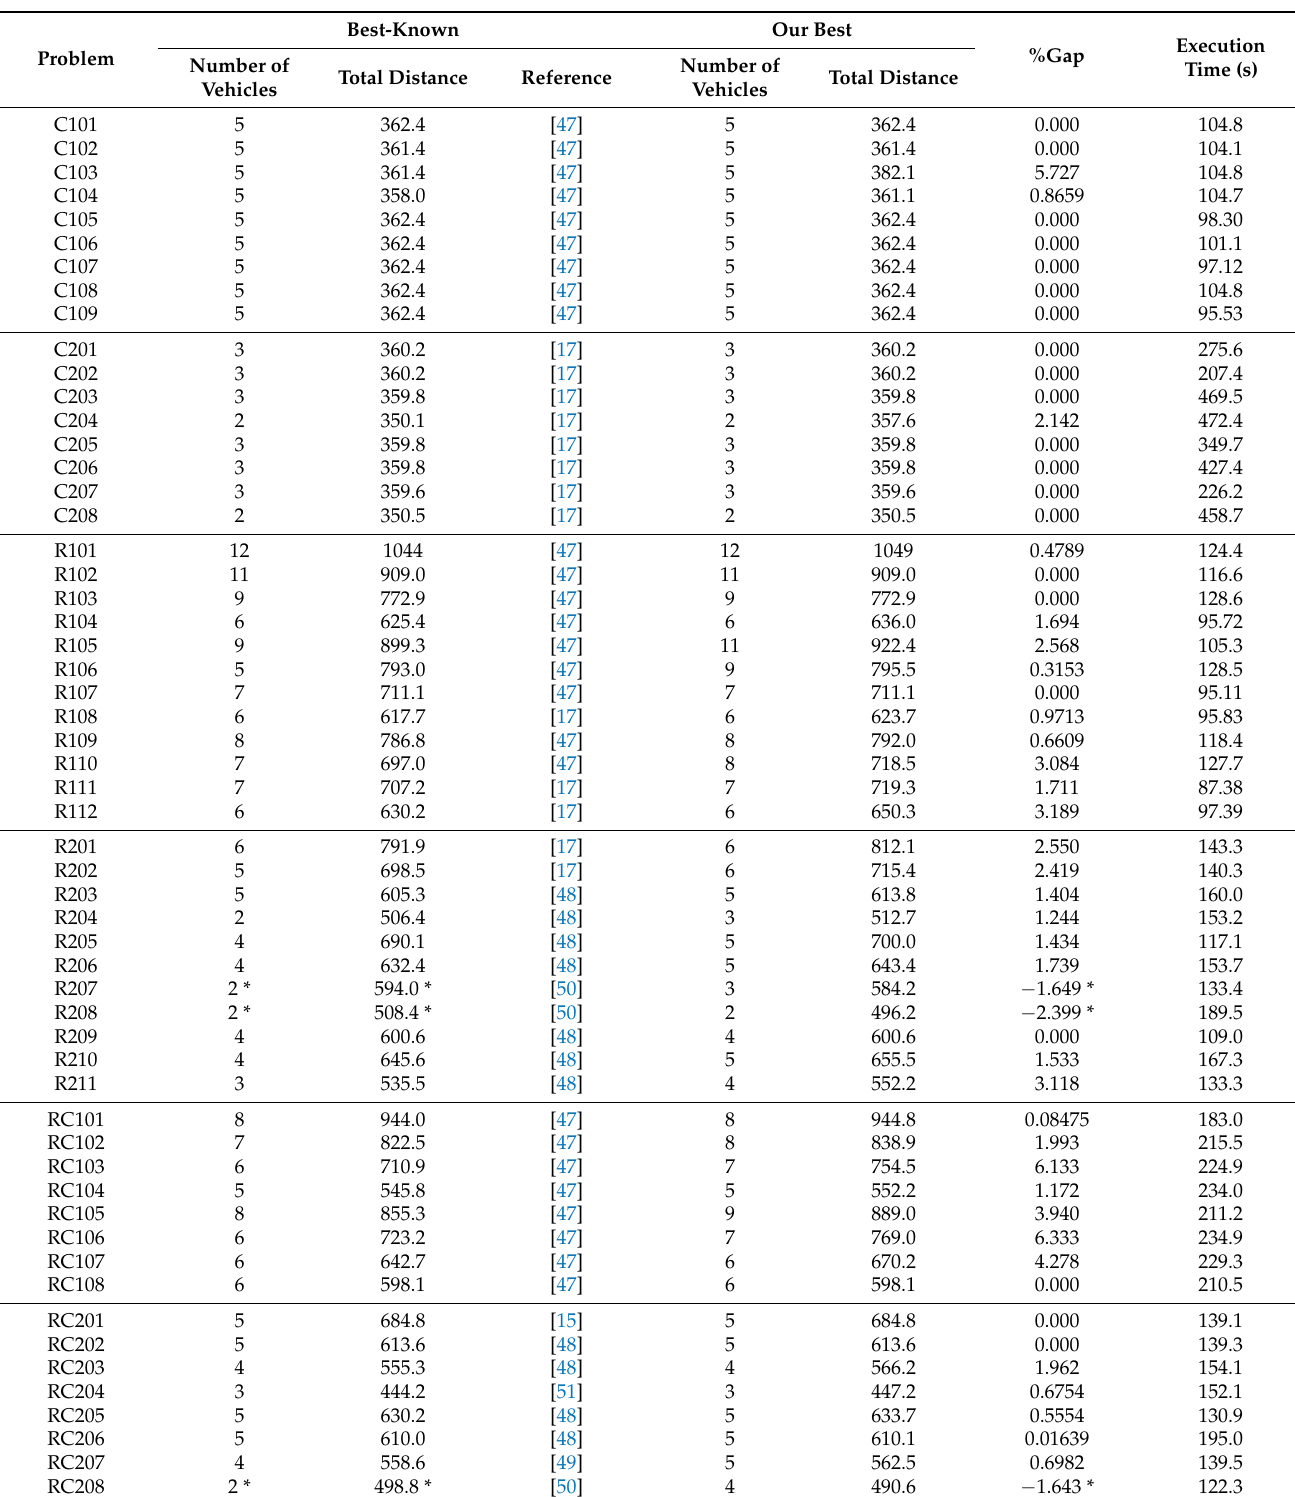
Table 4. Comparisons between the exact solution or best solutions (with “*”) and the results obtained by our heuristic on 50-customer Solomon